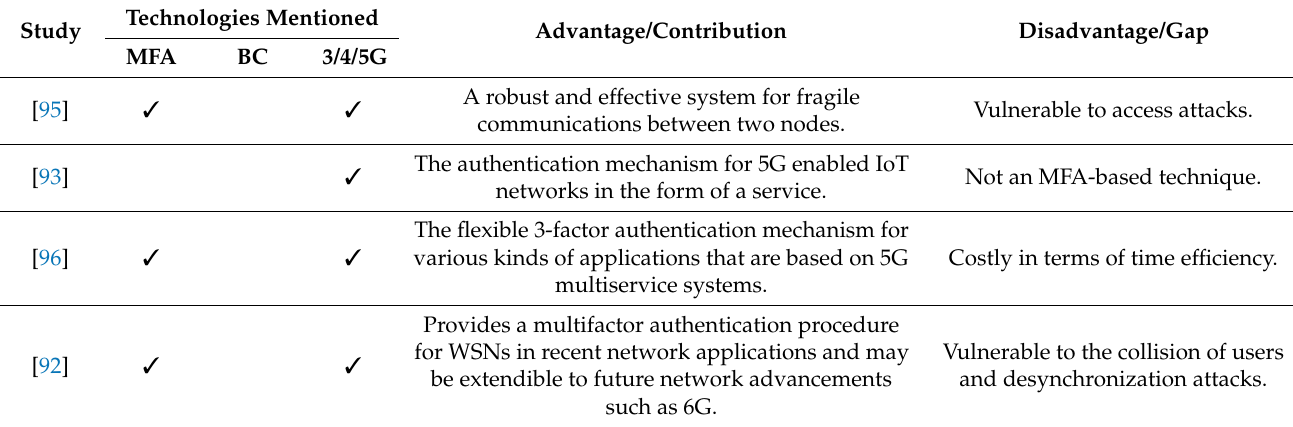
Table 4. Summary of Reviewed MFA and Blockchain Technology